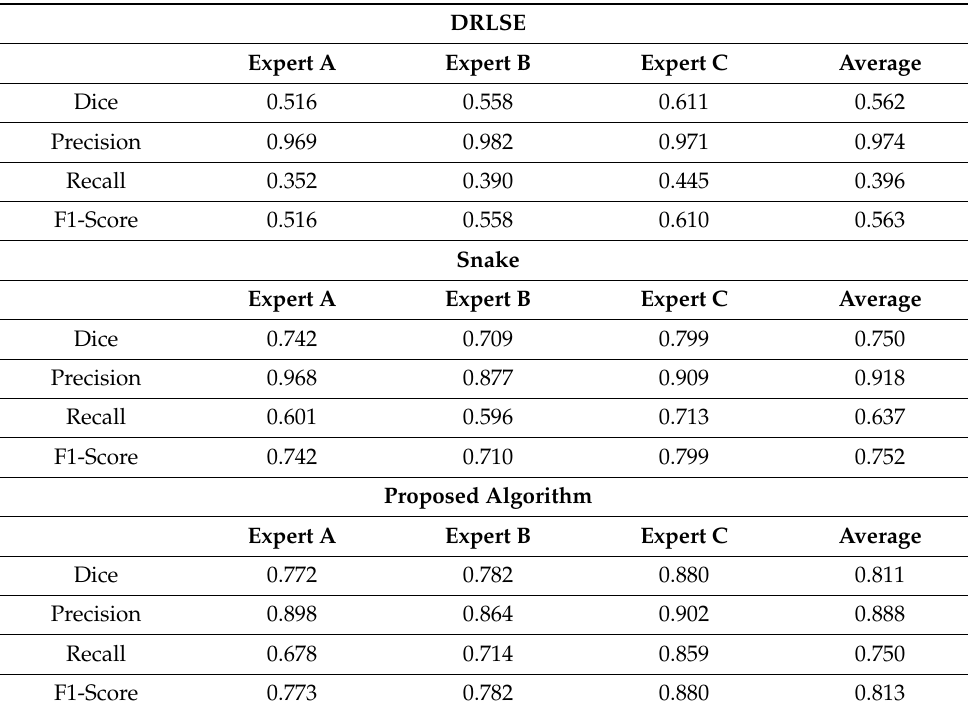
Table 1. Comparison of evaluation indexes of segmentation